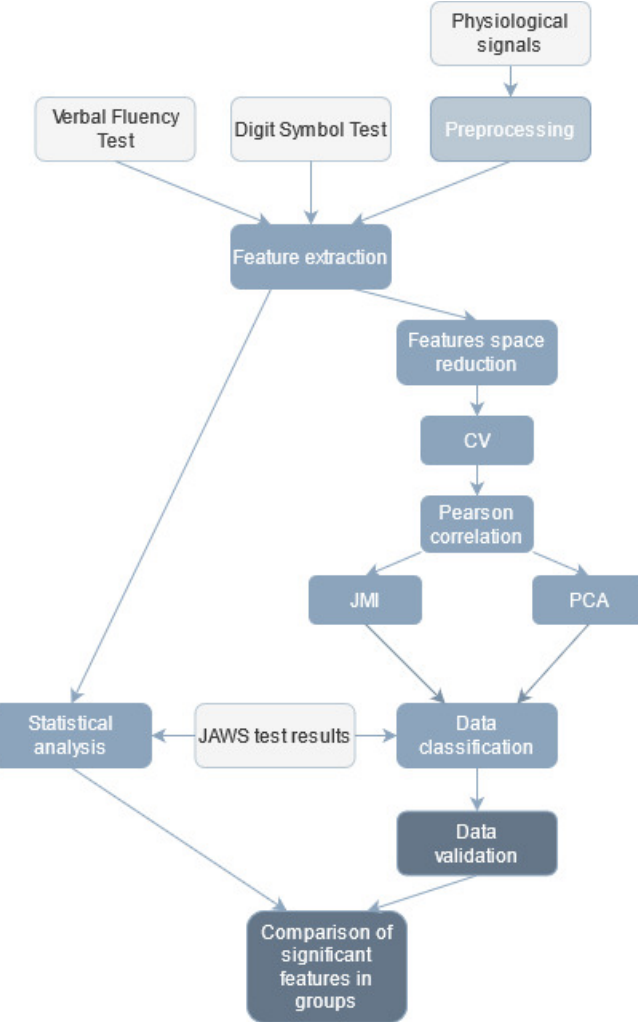
Figure 2. Workflow of data analysis (light grey—input data, medium grey—data classification, dark grey—data